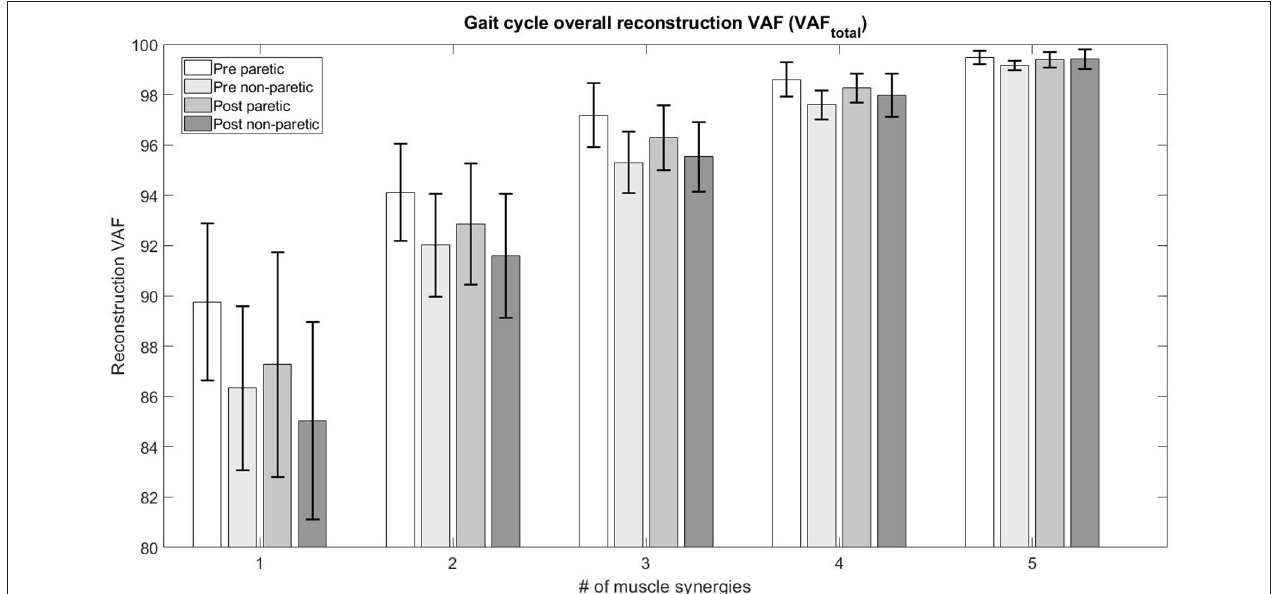
FIGURE 2 | Total variability accounted for (VAF total ) based on the number of muscle synergies.